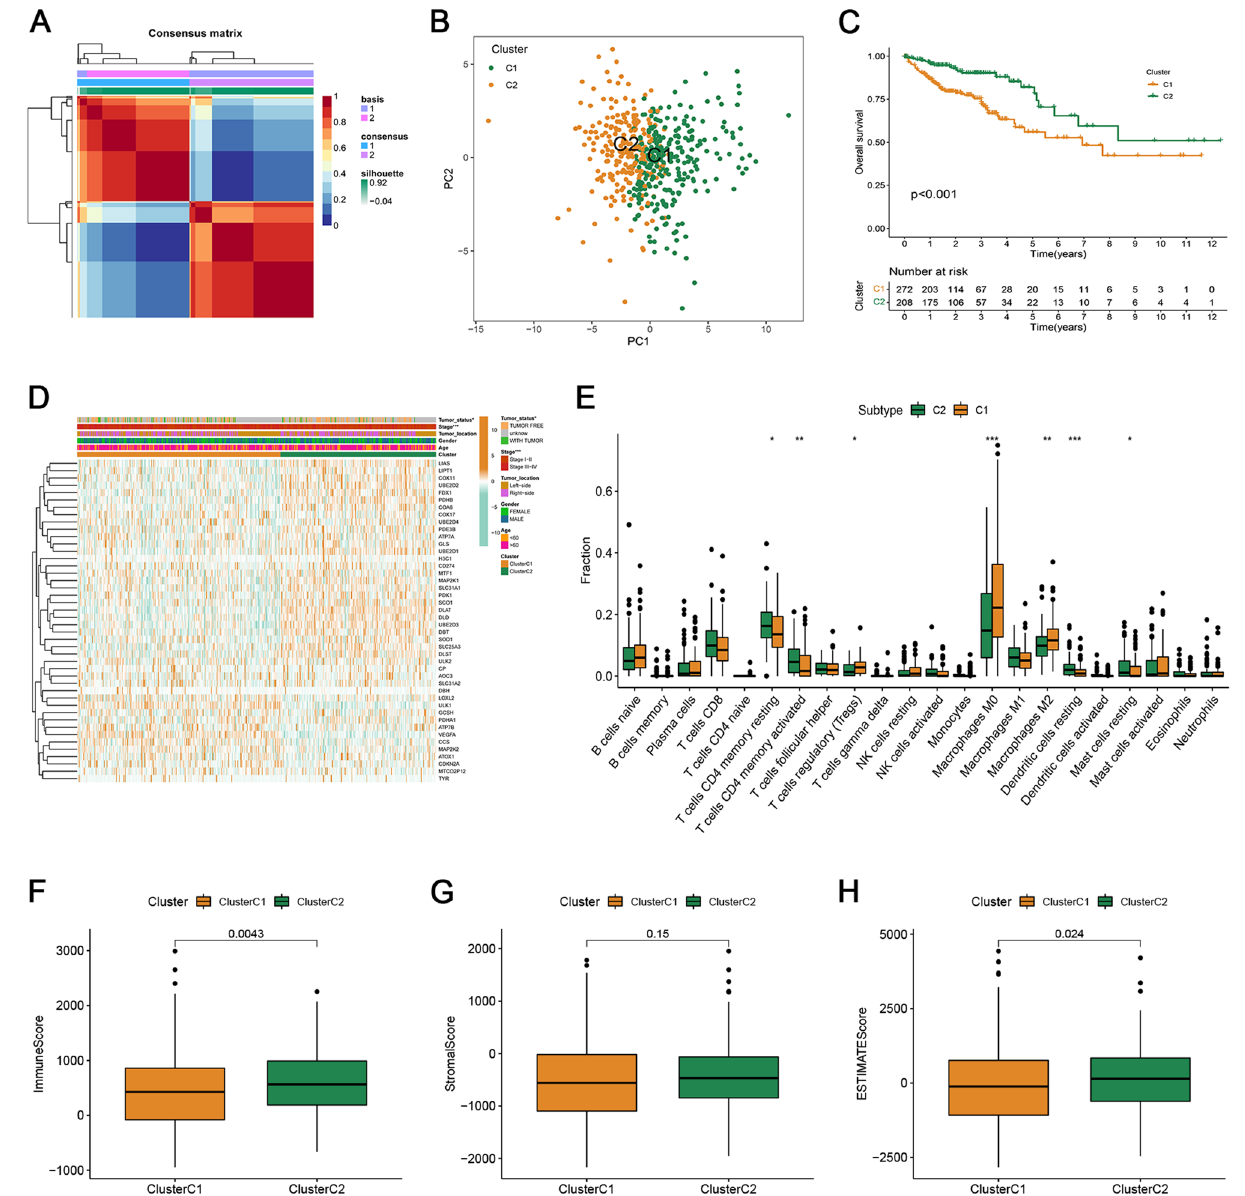
Figure 1. Identification of cuproptosis subtypes in CRC. ( A ) NMF consensus clustering for the k value was 2. ( B ) PCA revealed that the distribution of patients in two clusters goes in two directions. ( C ) Kaplan–Meier curve in the two subtypes. ( D ) Differences in clinicopathologic features between the two distinct subtypes. ( E ) The abundance of 22 infiltrating immune cell types in two distinct subtypes. ( F – H ) The immune, stromal, and estimate scores of two distinct